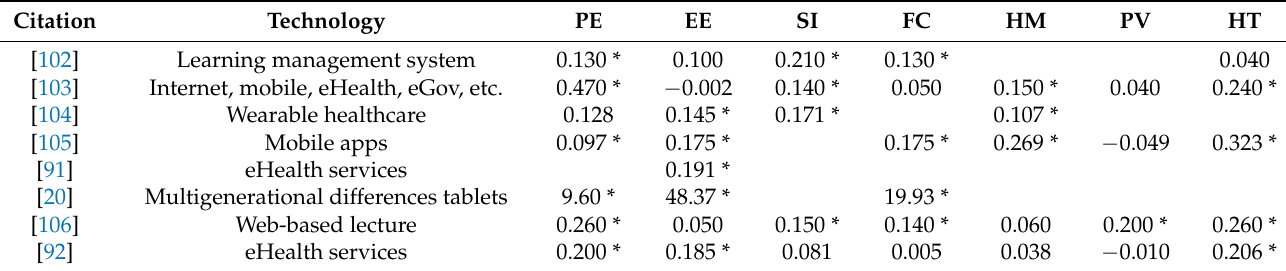
Table 1. Synthesis of consumer contextual